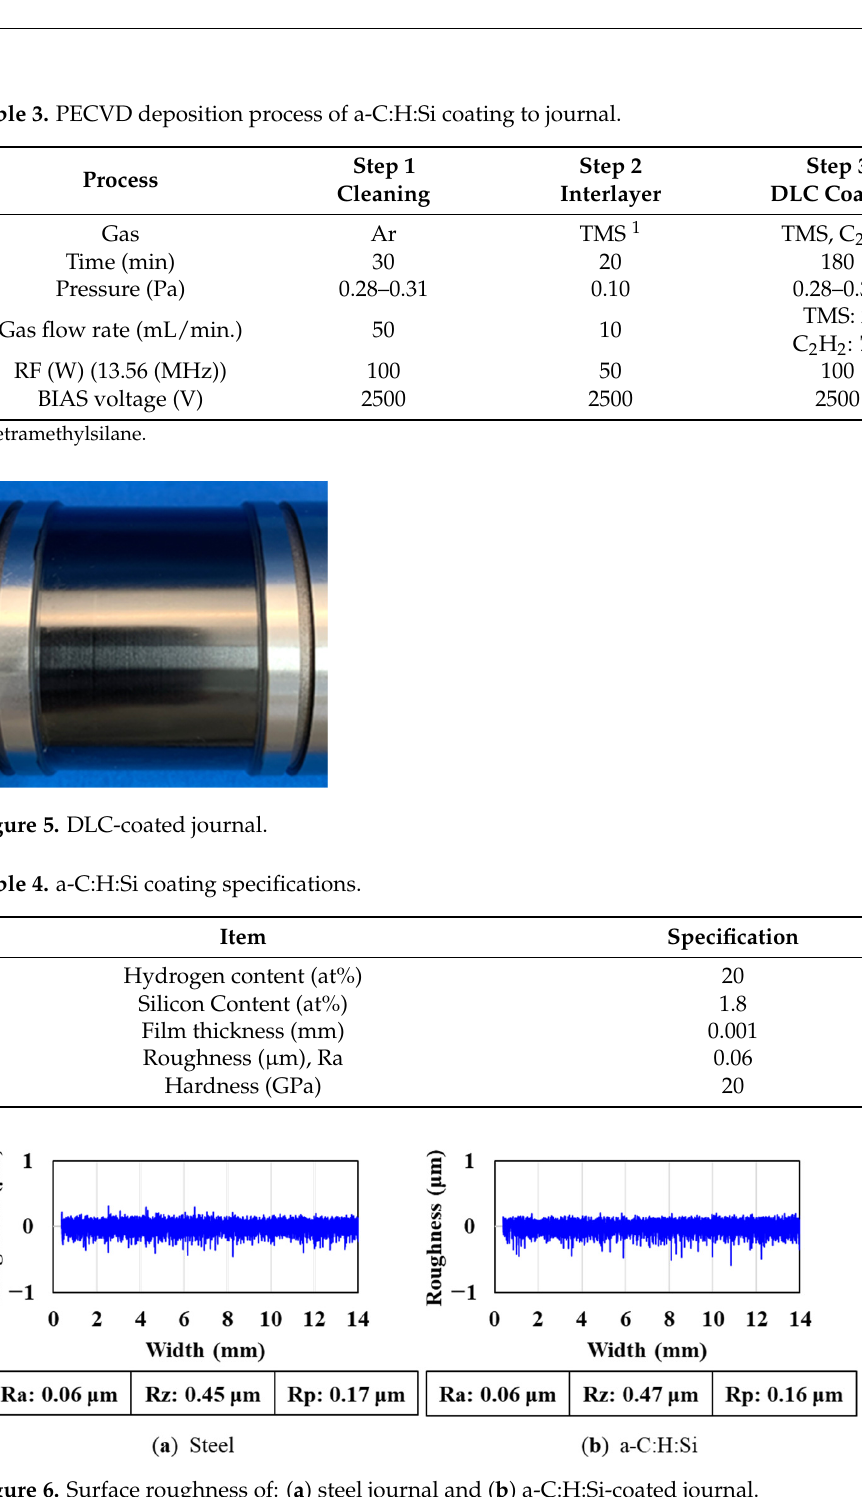
Figure 6. Surface roughness of: ( a ) steel journal and ( b ) a-C:H:Si-coated journal.